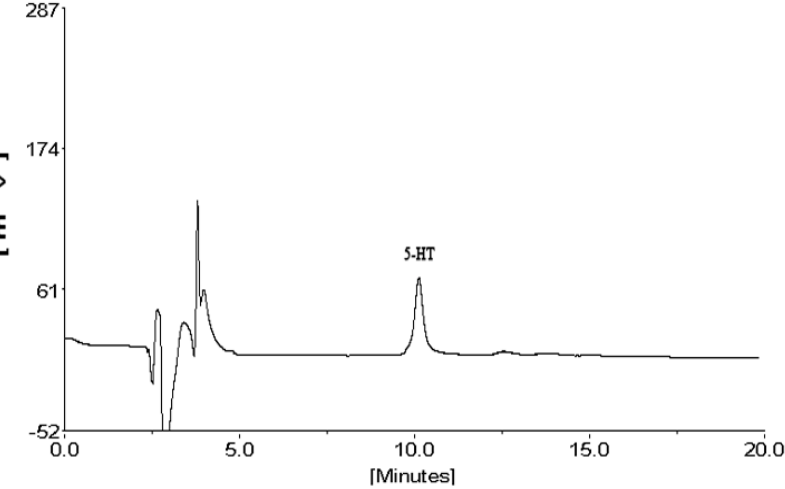
Figure 1. The HPLC chromatogram of serotonin.